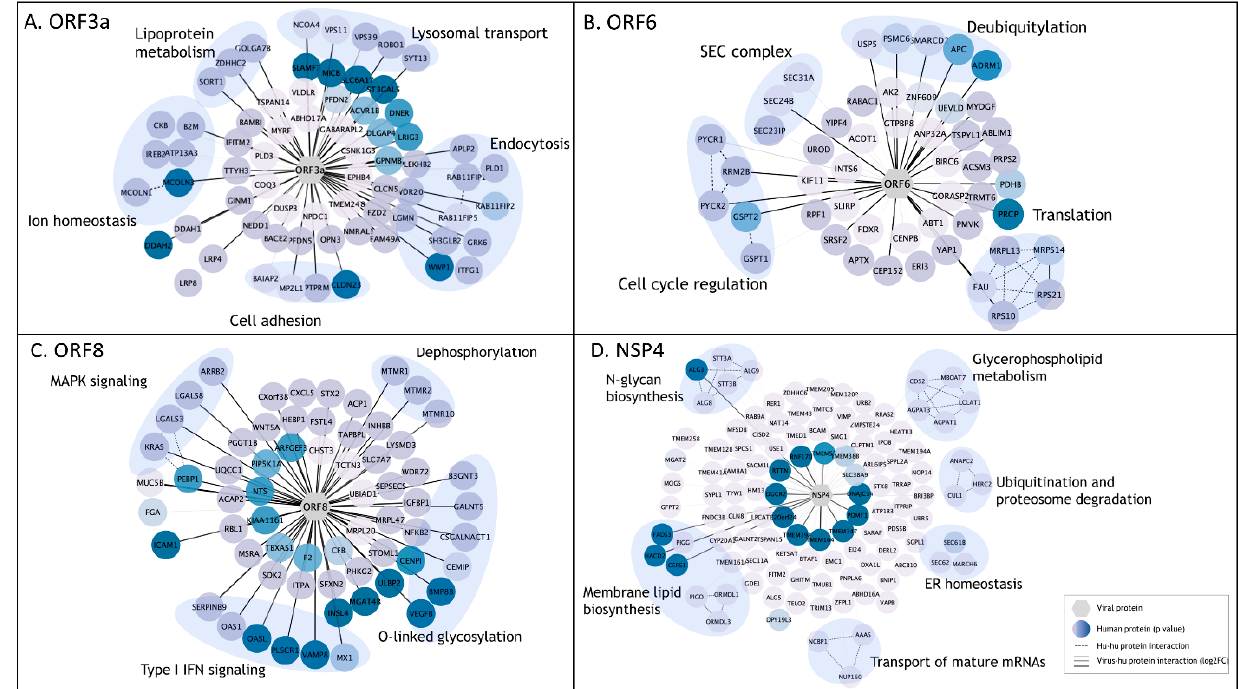
Figure 5. Enriched pathway analysis of PPIs for selected SARS-CoV-2 viral baits. ( A – D ). High-confidence associations between indicated SARS-CoV-2 proteins (hexagons) and human proteins (circles/nodes). Node color is proportional to the p value (the darkest, the lowest the p value). Human–human interactions as determined by STRING are represented by dashed edges. Human–viral interactions are indicated with solid edges, and their thickness are proportional to the log 2 FC (the thickest, the highest log 2 FC).